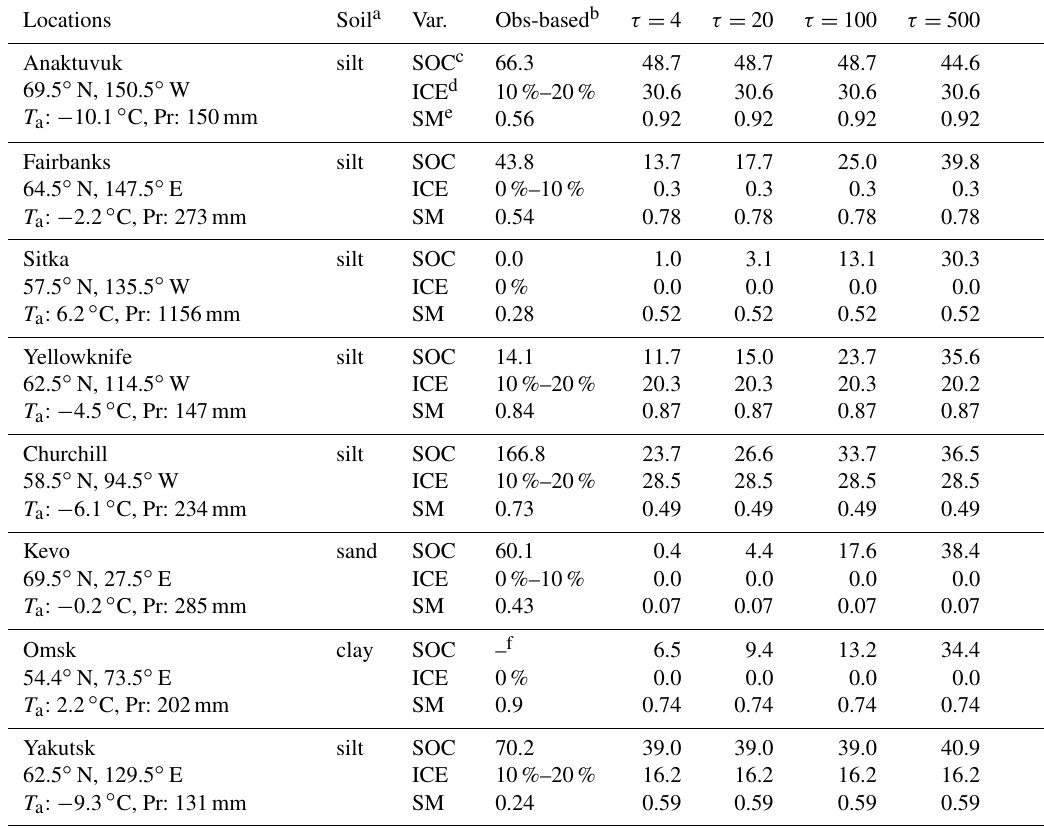
Table 2. Comparison of simulated SOC and ICE with observation-based data for eight locations. Longitude, latitude, the climatology of mean annual air temperature ( T a ) and annual total precipitation (Pr), and the simulated results are obtained from the values of the nearest 1 ◦ resolution grid point. τ denotes the relaxation timescale of decomposition